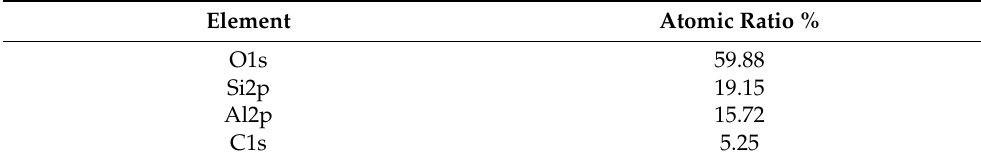
Table 3. Atomic composition for kaolinite powder.